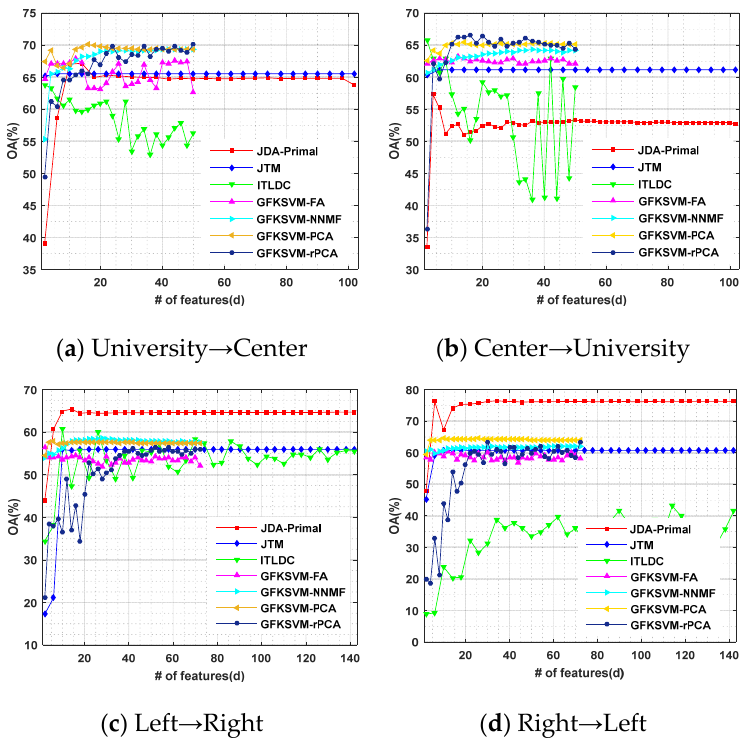
Figure 14. OA curves for GFKSVM and other considered state-of-the-art DA methods on ROSIS ( a , b ) and Houston ( c , d ) data sets.